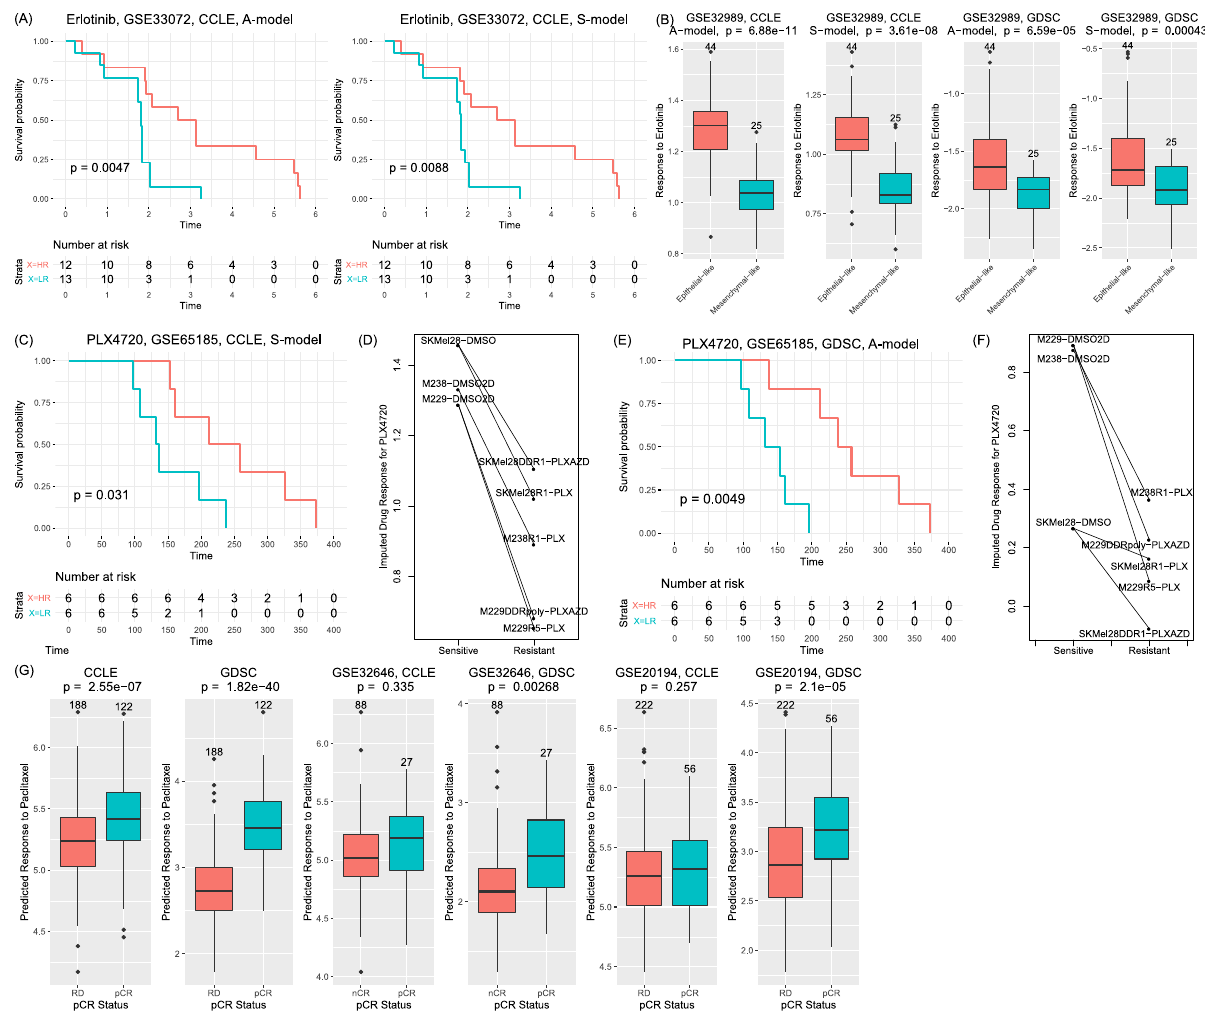
Fig. 5 Validation using independent datasets. A Survival analysis of samples from GSE33072 who were treated with erlotinib. The P value was from a log- rank test comparing two groups of samples de fi ned by the predicted response to erlotinib (HR: high response, greater than the median; LR: low response). B Comparison of predicted response to erlotinib in cell lines strati fi ed into epithelial-like ( n = 44) or mesenchymal-like ( n = 25) group using the dataset GSE32989. The P value was obtained by using a two-sided t test. C , E Survival analysis of melanoma samples treated with vemurafenib (data